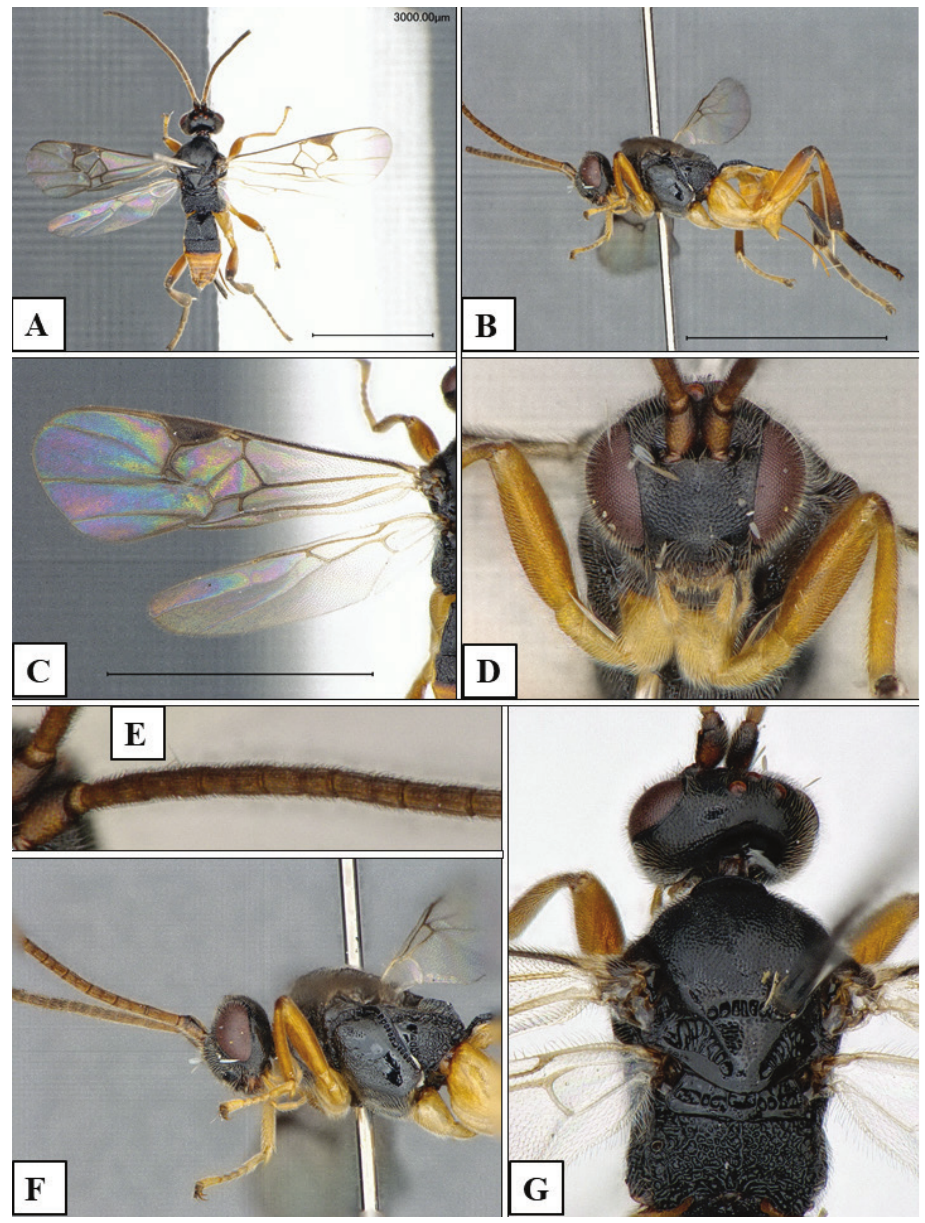
Figure 1. Microgaster godzilla , female holotype. A habitus dorsal B habitus lateral C wings D head, frontal E details of antenna F head and mesosoma, lateral G head and mesosoma,